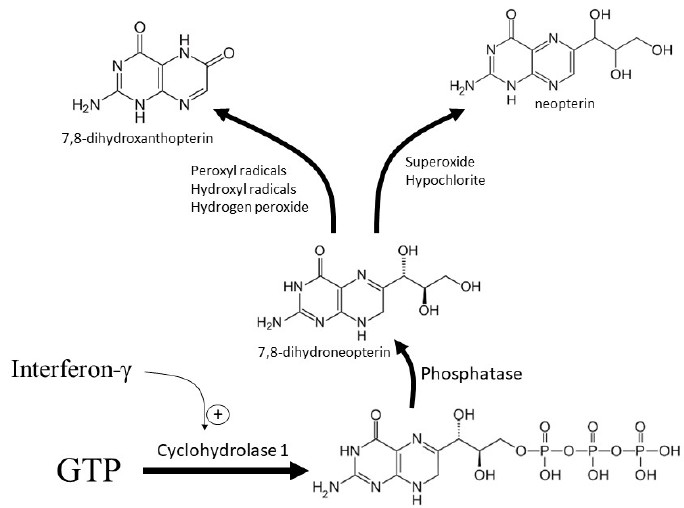
Figure 1. Formation and oxidation of 7,8 ‐ dihydroneopterin. In macrophages, interferon ‐γ upregulates